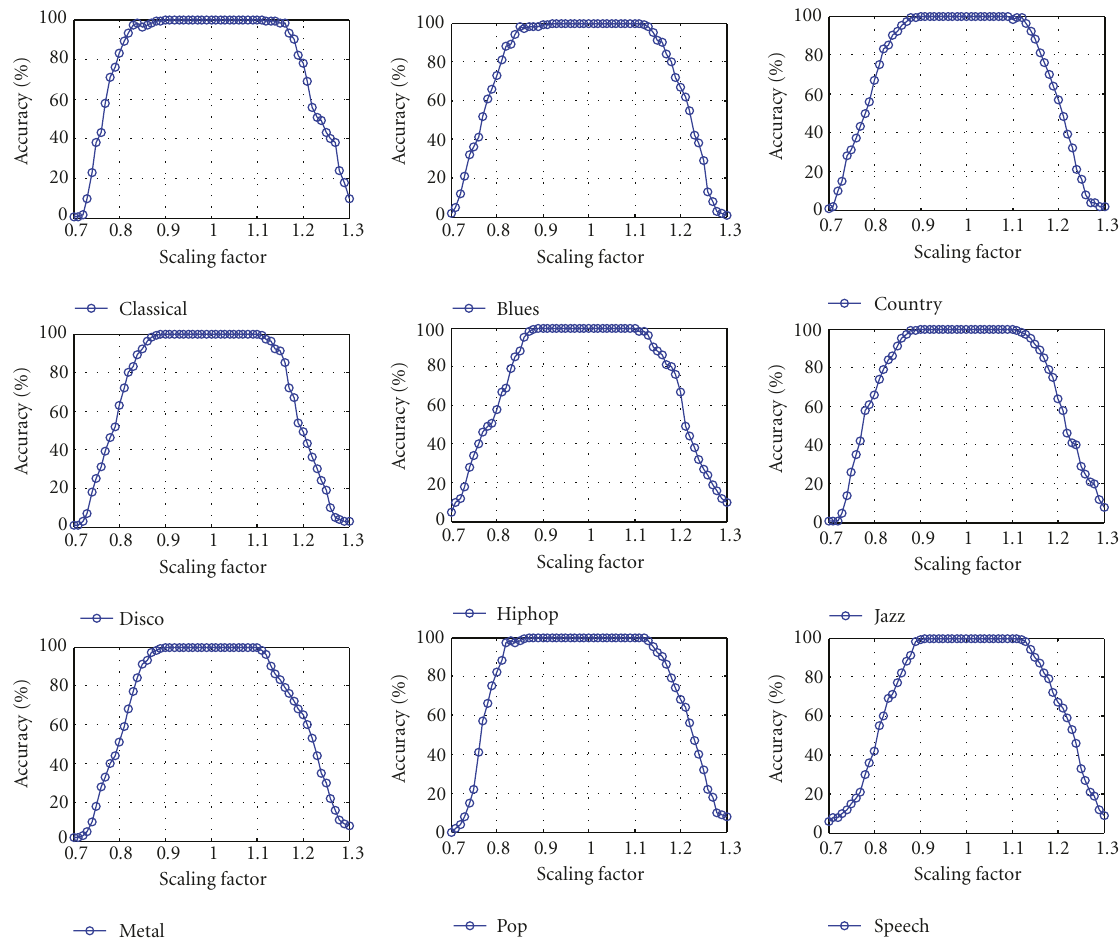
Figure 11: Robustness against pitch-invariant TSM.